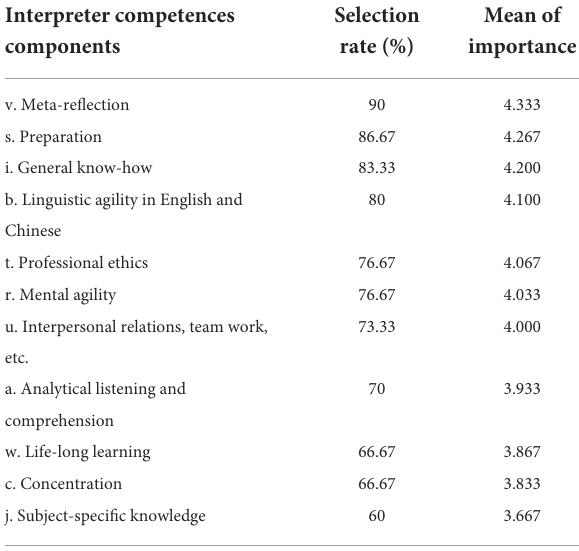
TABLE 6 Frequently selected components that contributed to the development of concern.